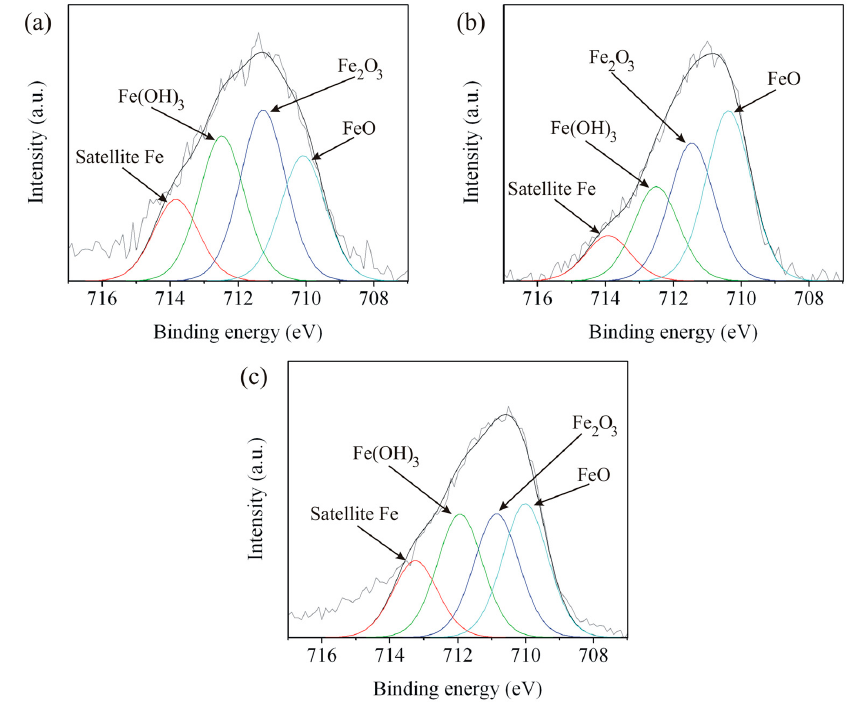
Figure 11. Fe 2p spectra of Zones: ( a ) A; ( b ) C; and ( c ) E.